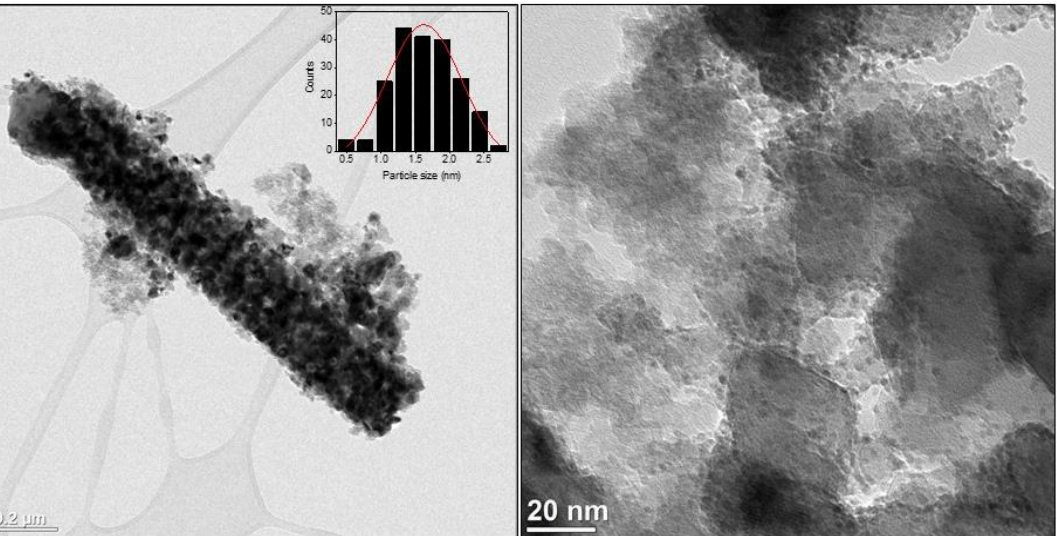
Figure 4. HRTEM images of Ru(2)-TiN tubes before reaction. Inset shows the particle size distribution.